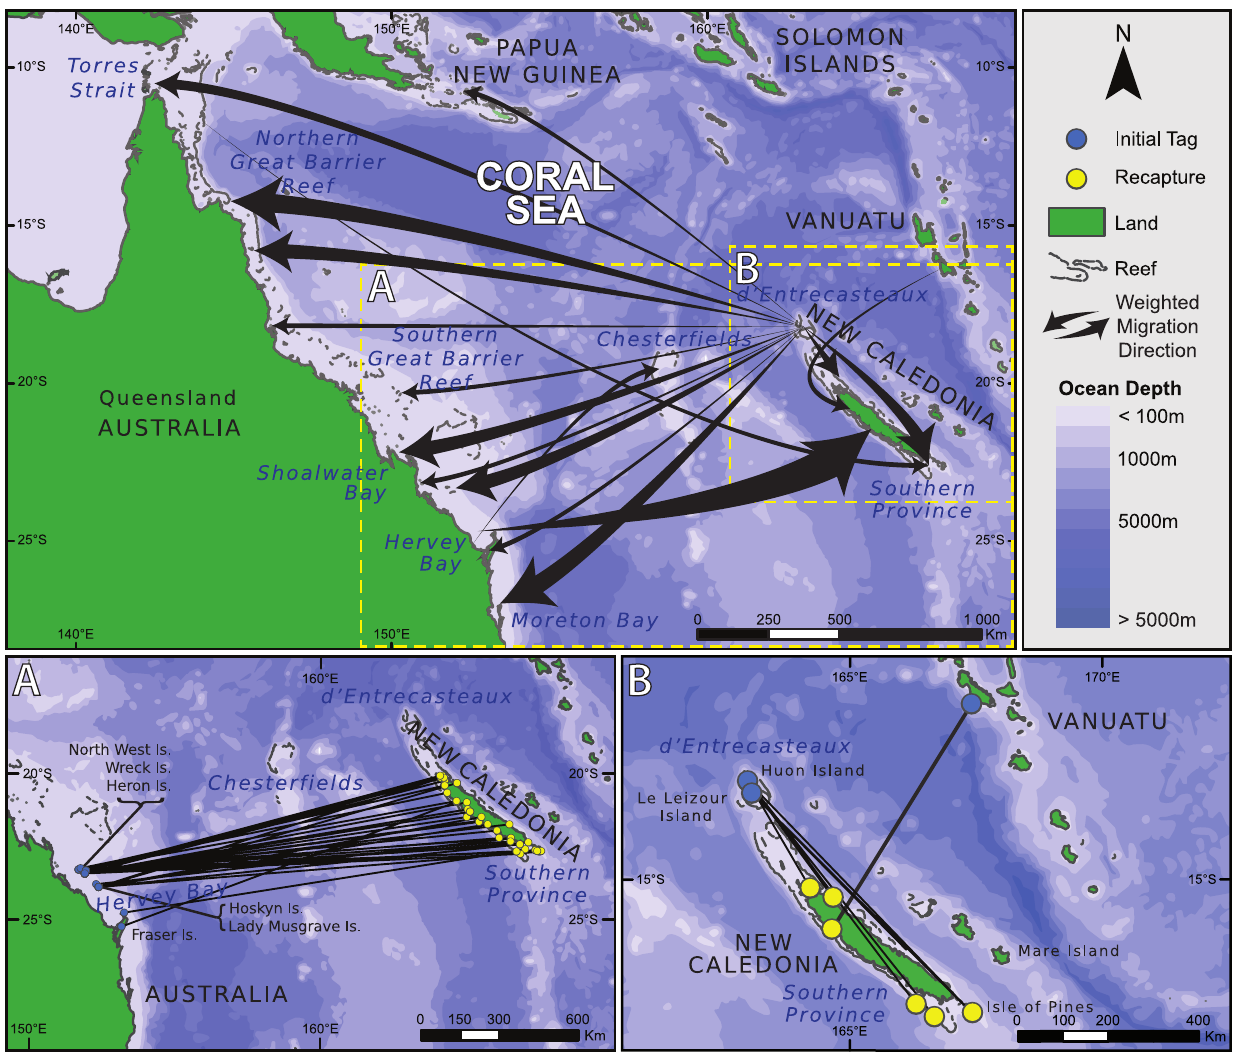
Figure 1. Trajectory maps obtained by the tag recoveries (n=93) and satellite tracking of C.mydas in the Coral Sea (n=1).